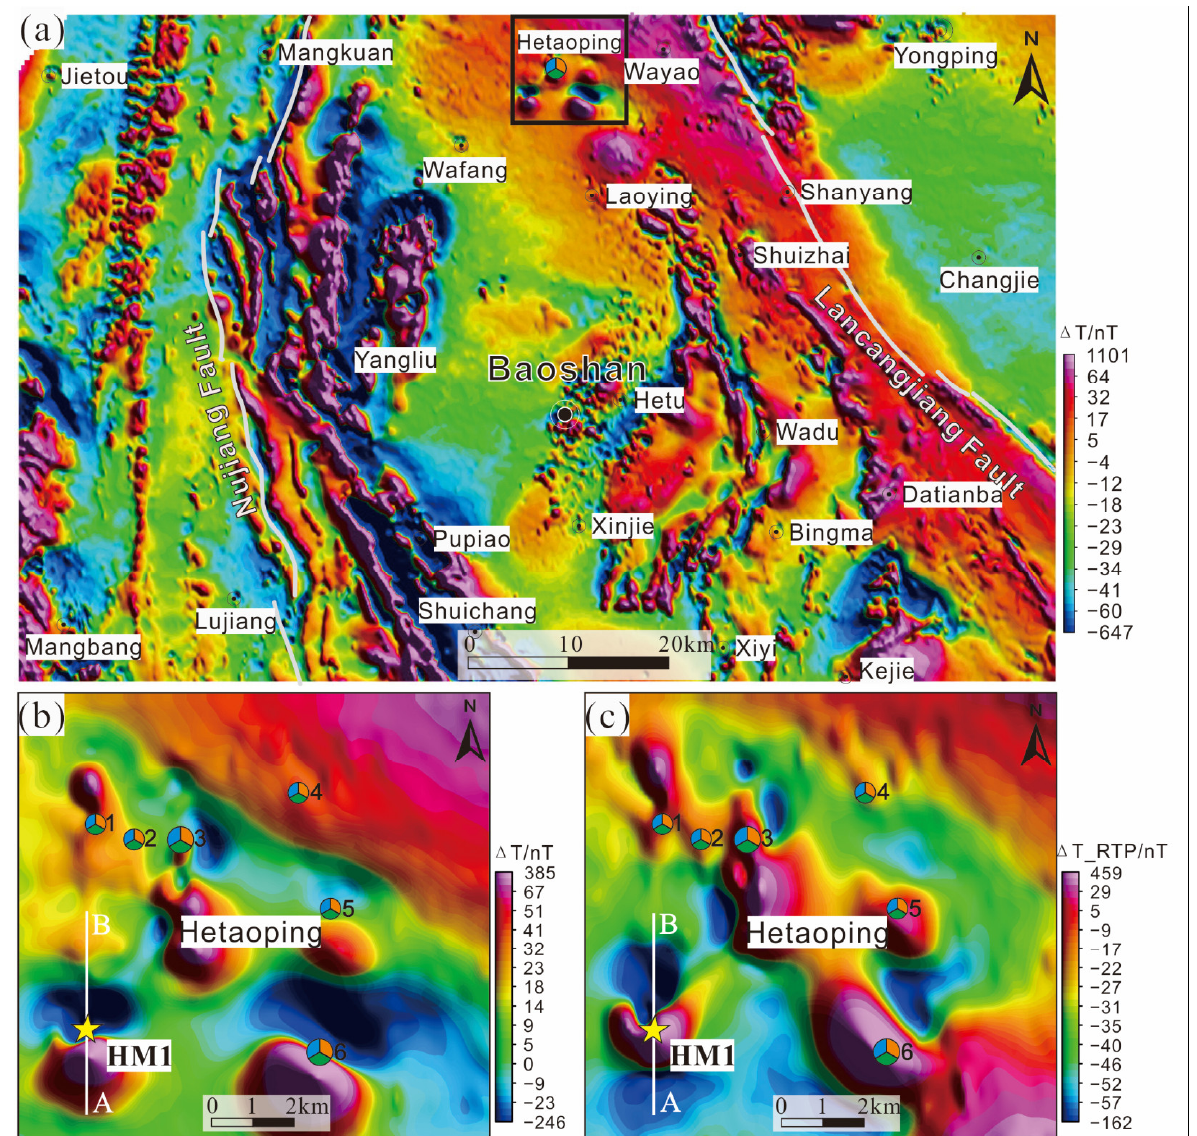
Figure 3. Aeromagnetic and RTP-transformed aeromagnetic shadow contour map of the study area. ( a ) Regional total magnetic intensity (TMI) shadow contour map. ( b ) TMI shadow contour map of Hetaoping ore district. ( c ) RTP-transformed aeromagnetic anomalies in Hetaoping ore district. Line AB is the location of the survey line, along which the ground magnetic, geological, and geochemical surveys were carried out. HM1 is the number of the aeromagnetic anomaly to be studied.